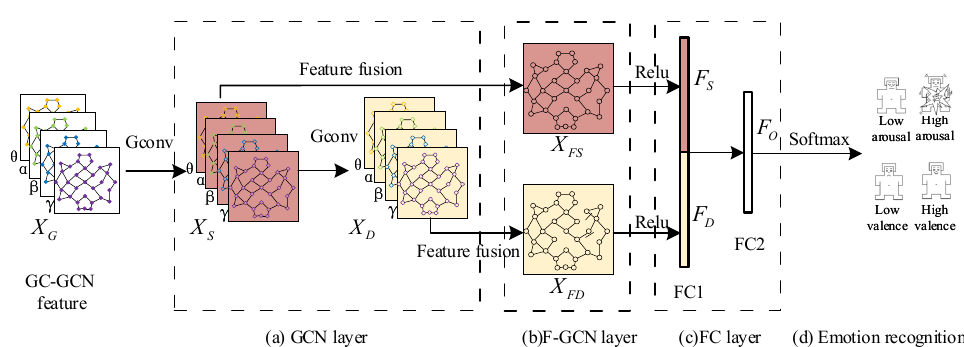
Figure 3. The framework of the proposed GC-F-GCN feature fusion